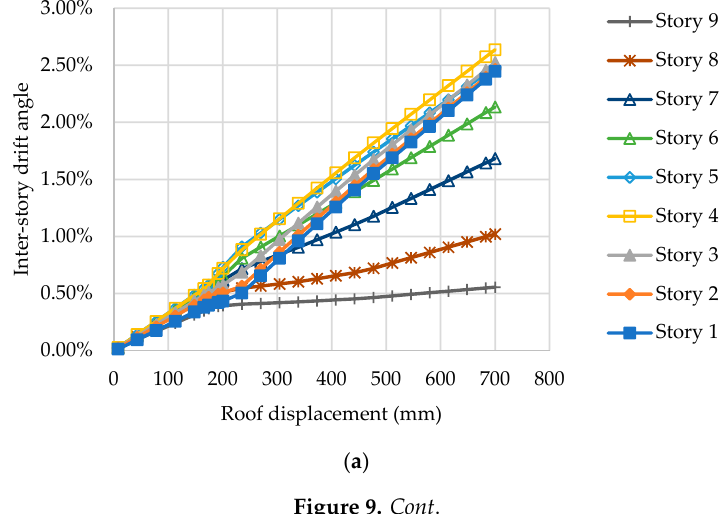
Figure 8. Cable axial force response under ( a ) LD-P and ( b ) LD-U.